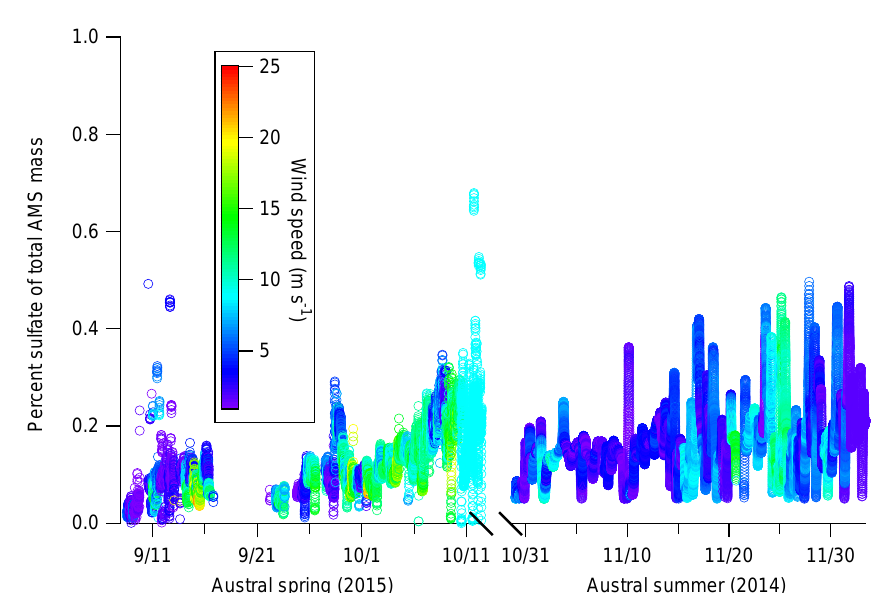
Figure A1. Mass of sulfate as a percent of total non-refractory mass measured in the AMS, colored as a function of wind speed, for both field seasons.